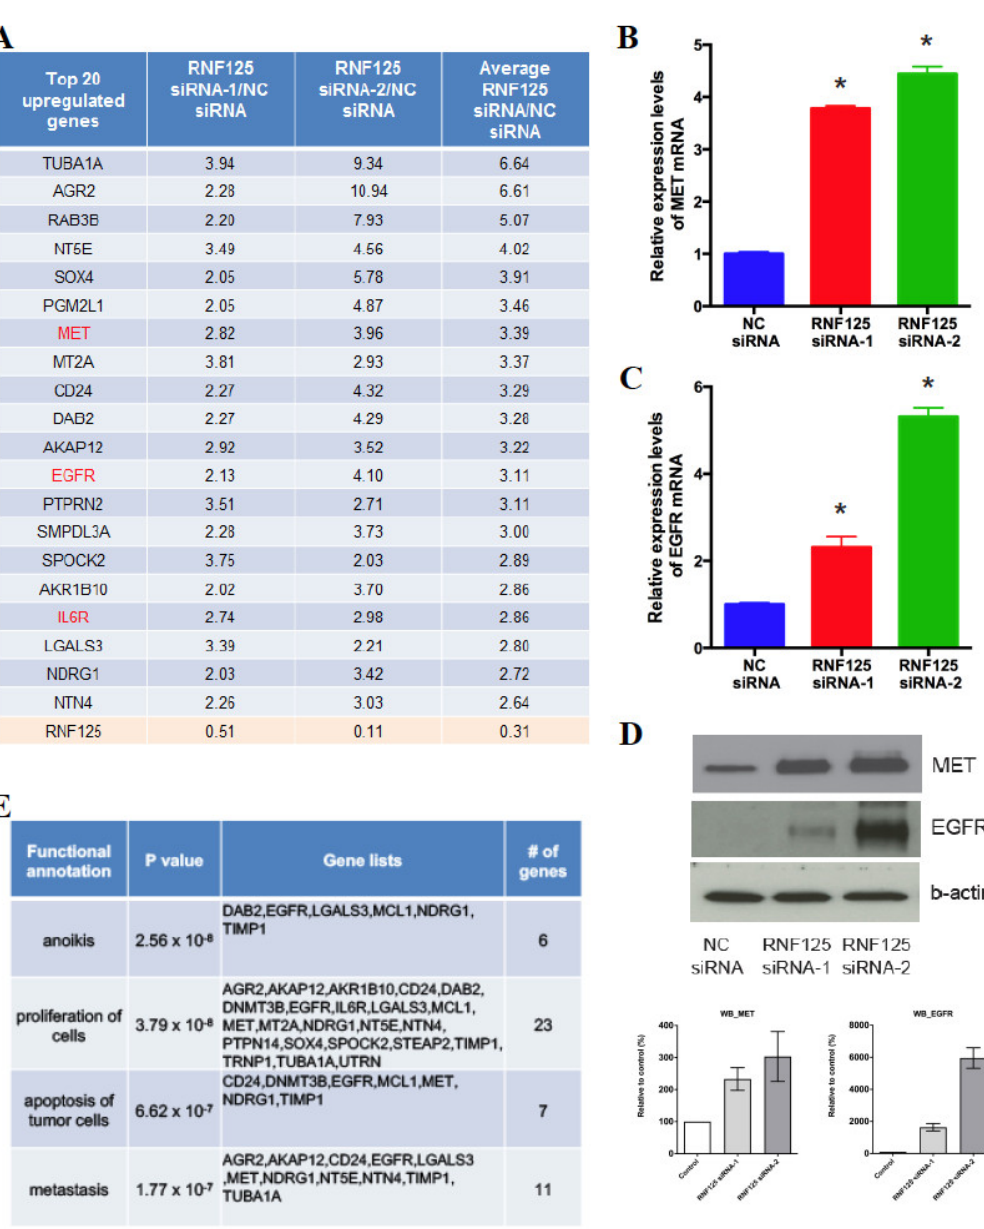
Figure 4. Rnf125 transcriptionally suppresses global cell proliferation machinery. ( A ) HepG2